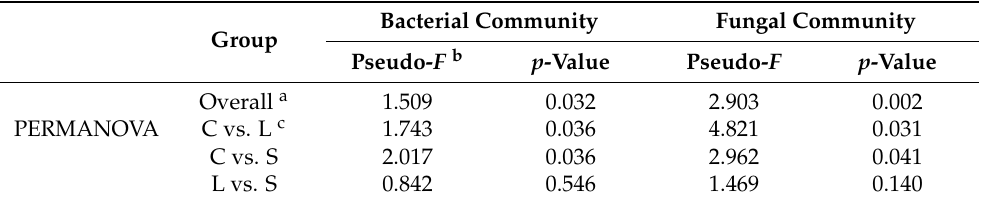
Table 4. The tests of significant value of Bray–Curtis distance matrix when comparing the influences of Stropharia rugoso- annulata cultivation on soil bacterial and fungal communities.